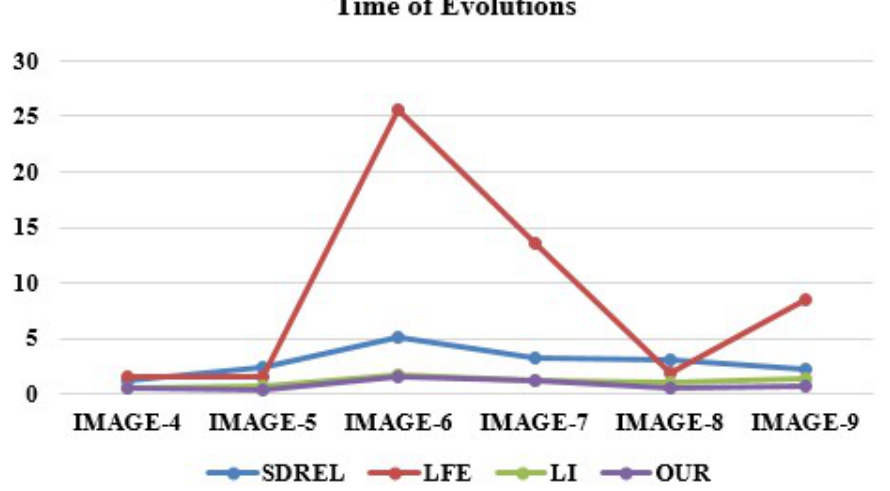
Figure 9. Comparison of our algorithm with three state-of-the-art methods on the basis of time in seconds.